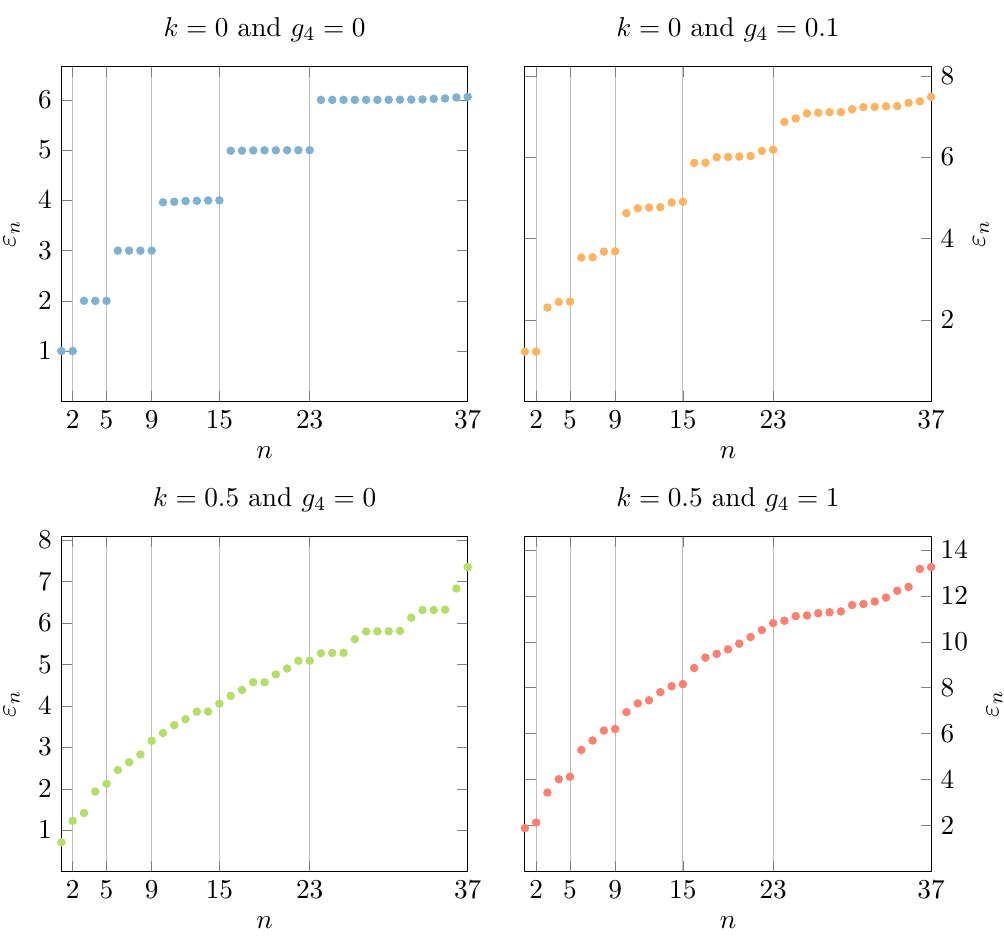
Figure 3. Two-matrix spectrum plots and degeneracy lifting due to g 4 and k